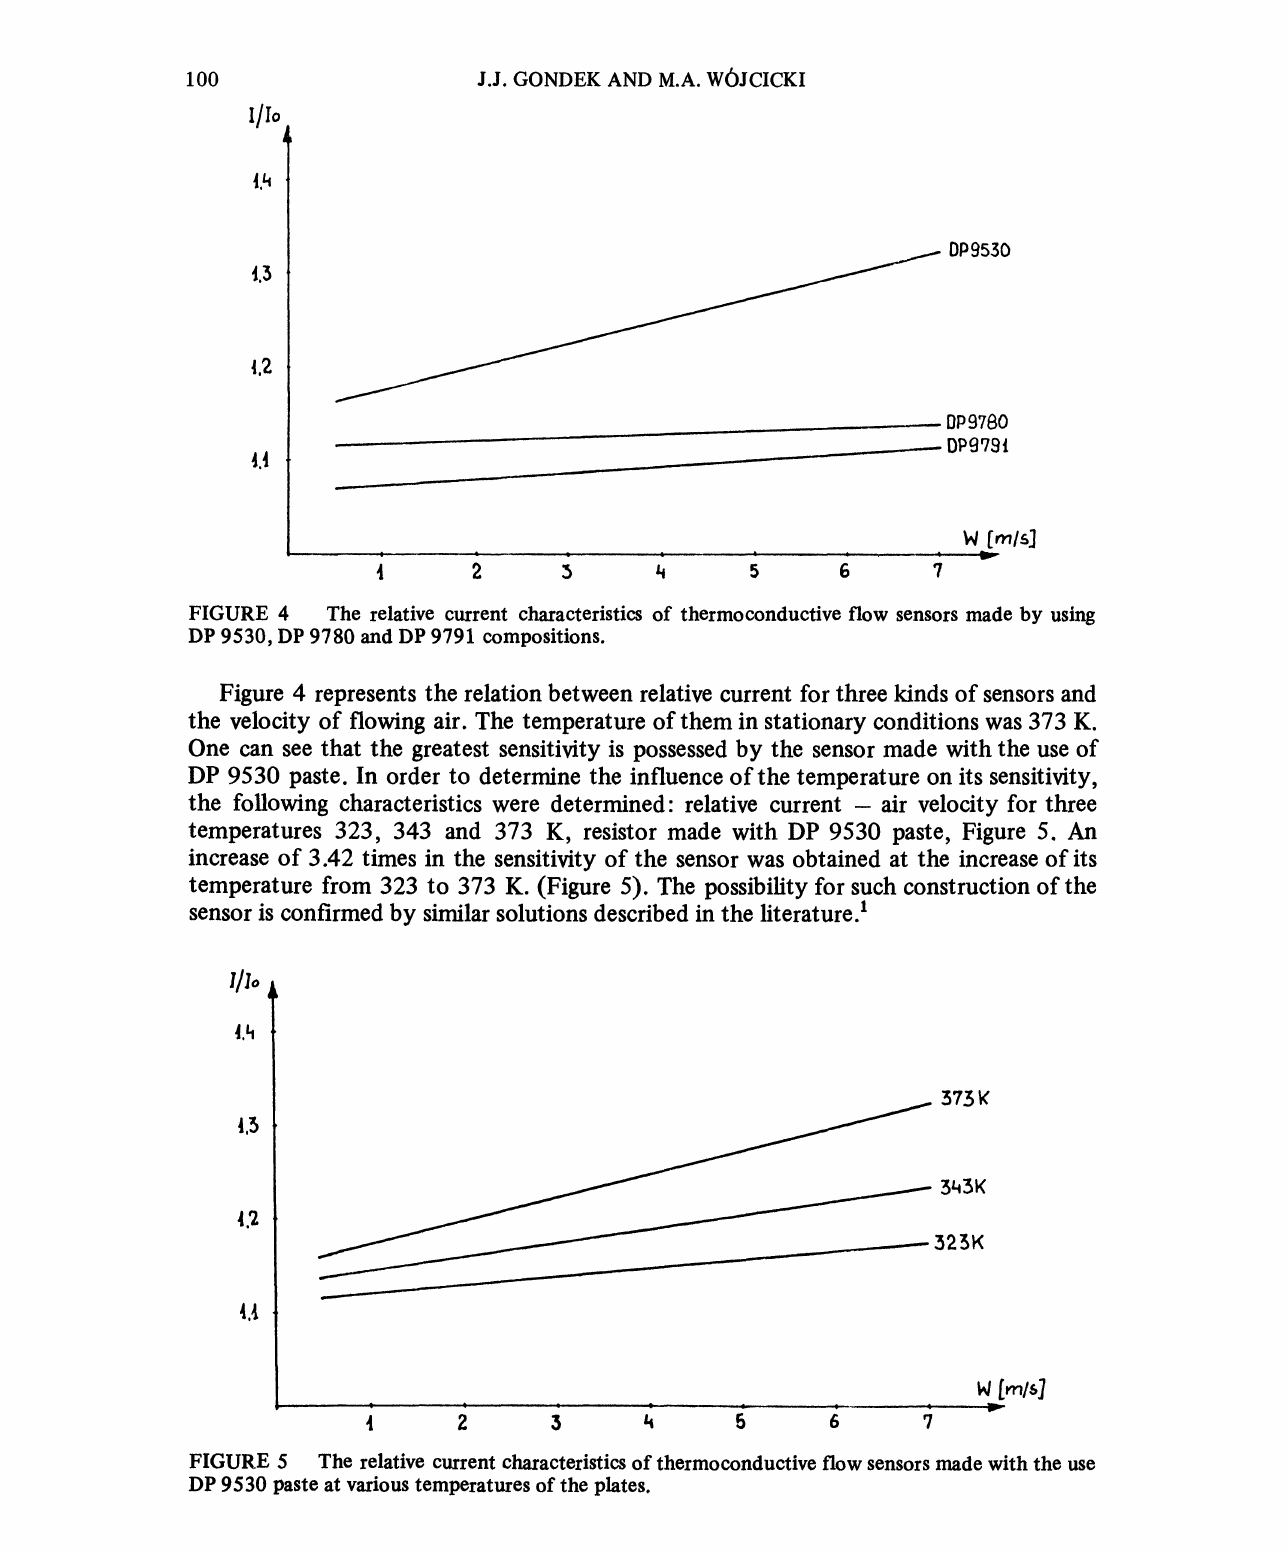
FIGURE 5 The relative current characteristics of thermoconductive flow sensors made with the use DP 9530 paste at various temperatures of the